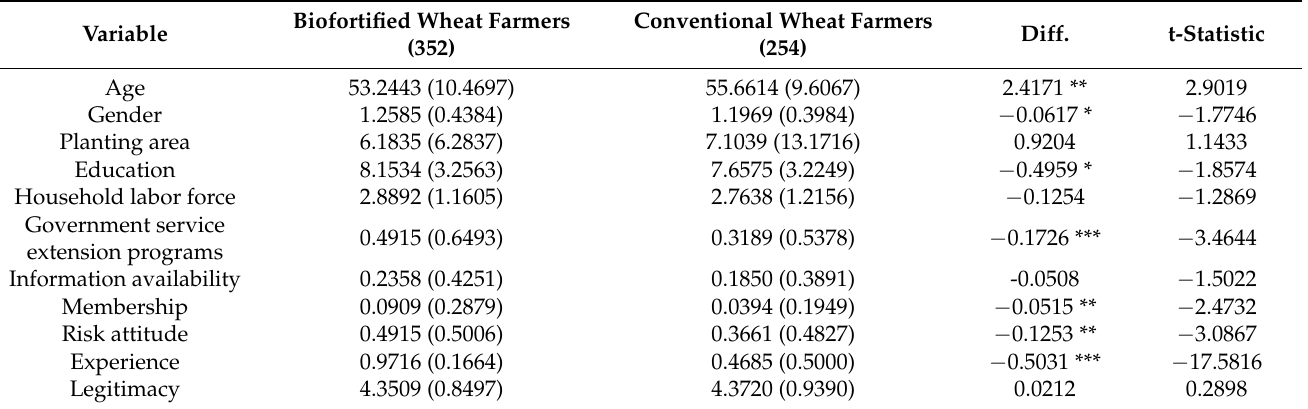
Table 2. Mean differences in characteristics between biofortified wheat farmers and conventional wheat farmers.